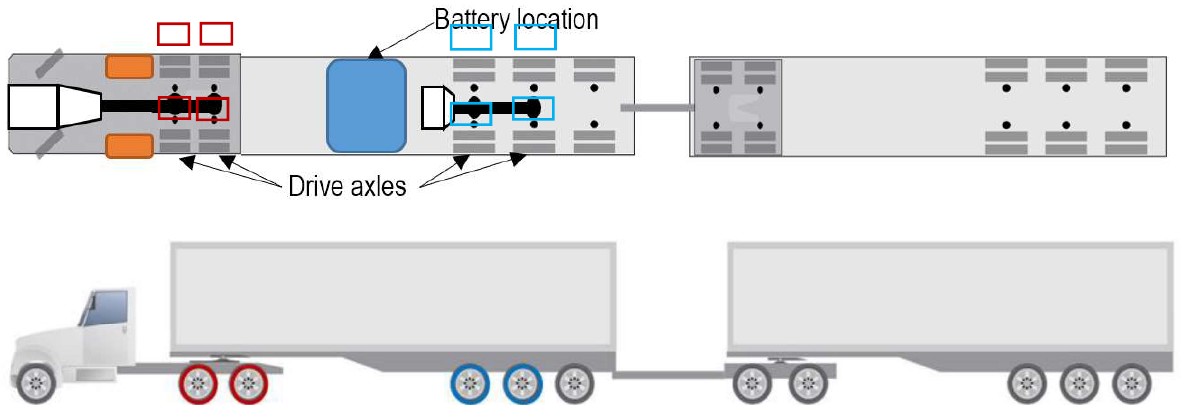
Figure 7. Top and front views of a TTRP hybrid multi-articulated vehicle: Red wheels: traction from diesel engine; blue wheels: traction from electric motor. Table 2. Multi-articulated vehicle specifications.